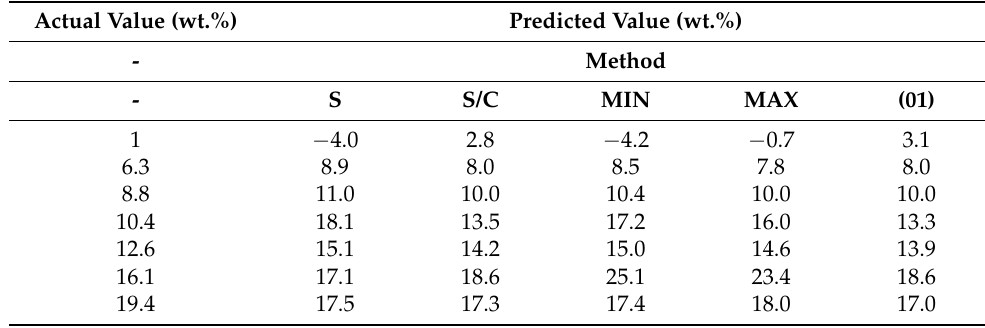
Table 6. Actual and predicted values of the different calibration methods.